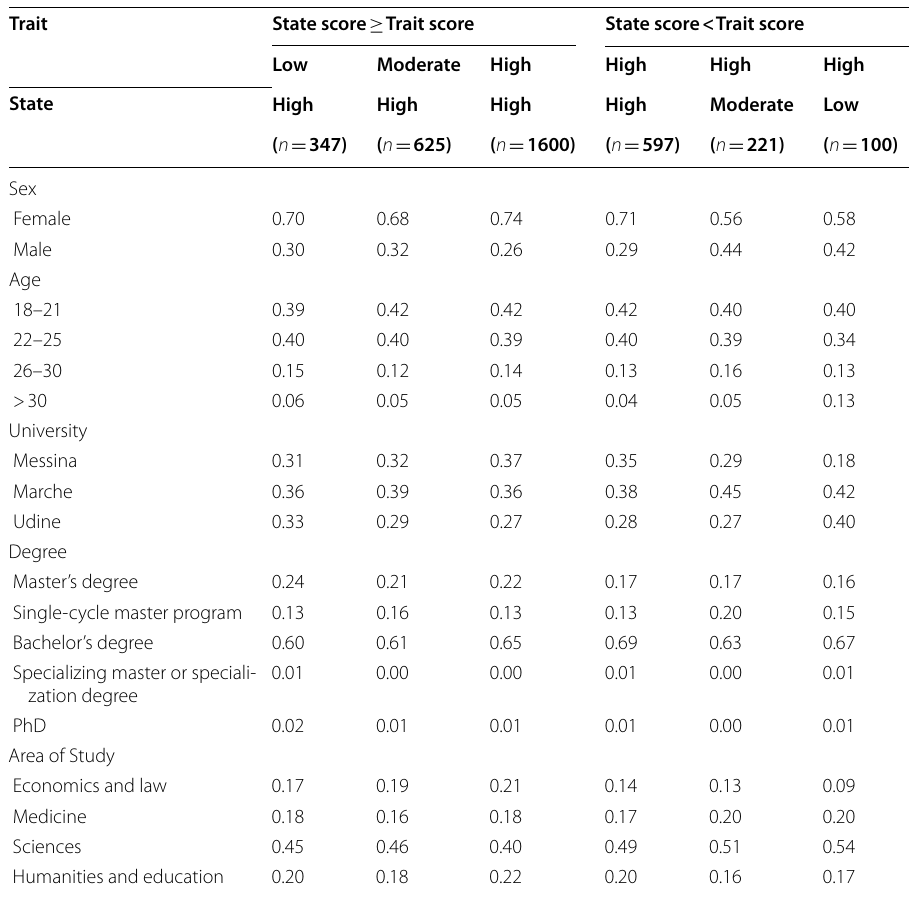
Table 5 Composition of the sample by trait and state anxiety Trait State score